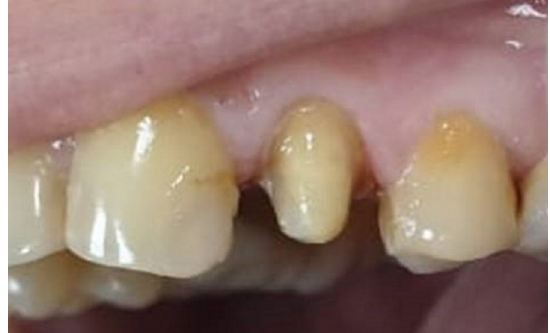
Fig. 2 Prepared left maxillary first premolar with deep chamfer finish line